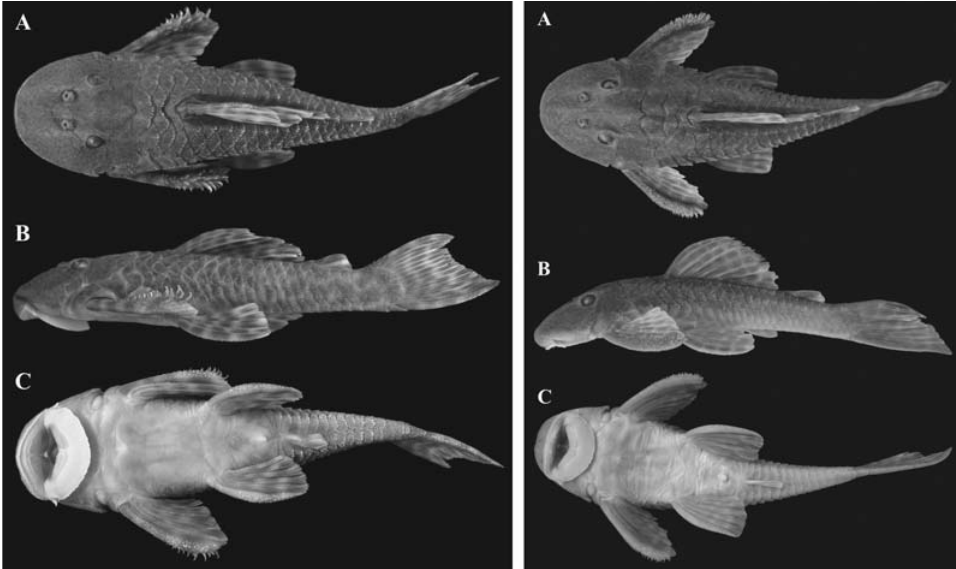
Table 1 - Enzyme, Enzyme Commission number (EC n.), tissue, buffer and quaternary structure (QE) of enzymes analyzed in Hypostomus , Hypostomus nigromaculatus and Hypostomus cf. nigromaculatus from the Atlântico Stream (Paraná State, Brazil) by the corn-starch gel electro- phoresis technique.